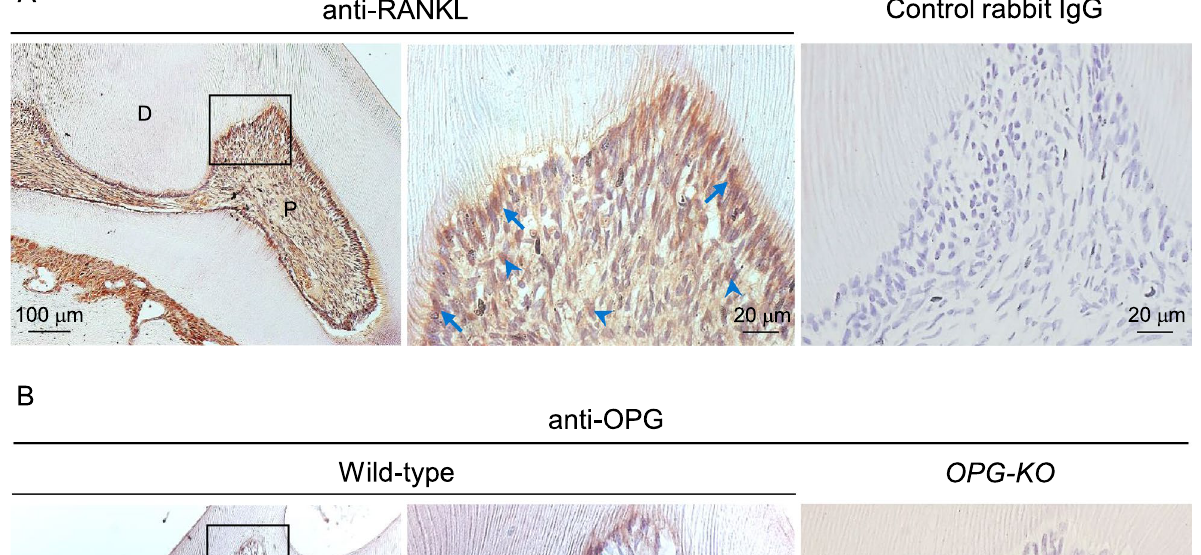
Figure 1. Odontoclast regulatory molecules are expressed but anti-differentiation factor OPG is dominant in the dental pulp environment. ( A , B ) Representative images of 6-week-old mouse maxillary first molars stained with anti-RANKL ( A , left and middle panels) and anti-OPG ( B , left and middle panels) antibodies. n = 3. Blue arrows: RANKL + odontoblasts, blue arrowheads: RANKL + pulp stromal cells, red arrows: OPG + odontoblasts, red arrowheads: OPG + pulp stromal cells. Normal rabbit IgG ( A , right panel) and sections from OPG-KO mice ( B , right panel) were used as negative control, respectively. Right panels are magnified views of boxed areas. P: pulp, D: dentin. ( C – E ) Real-Time PCR analysis of Csf-1 , Rankl, and Opg expression in 6-week-old mouse femora and maxillary first molars normalized with Gapdh ( C ) or Col1a1 ( D ). Relative ratio of Rankl to Opg normalized with Gapdh (left panel) or Col1a1 (right panel) ( E ). Femora: n = 5, Molars: n = 5. * p < 0.05, ** p < 0.01, *** p < 0.001. Data are represented as mean ±